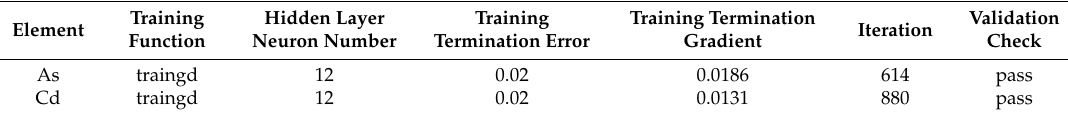
Table 1. Relevant test parameters of the BP neural